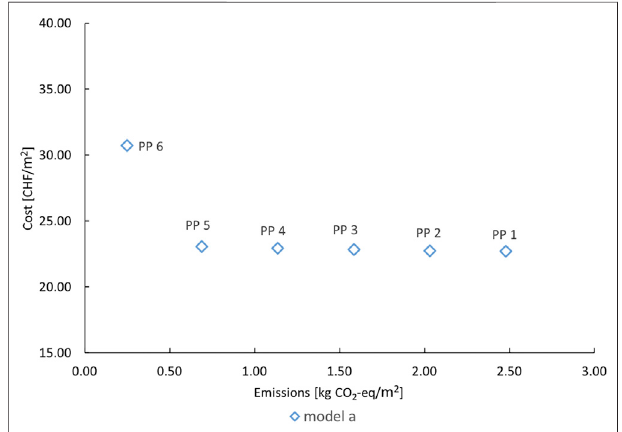
FIGURE 4 | Pareto fronts of speci fi c emissions vs. equivalent annual costs.